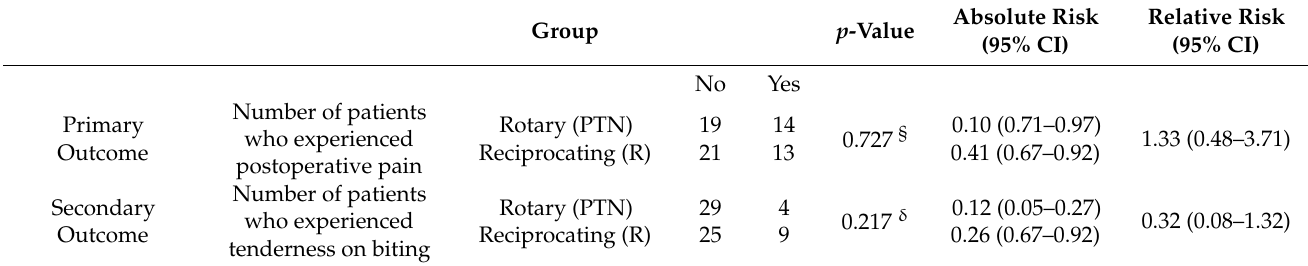
Table 3. Absolute and relative risk of postoperative pain (extracted from the NRS) and tenderness on biting (extracted from the yes-or-no question) after instrumentation (including all time intervals) for both